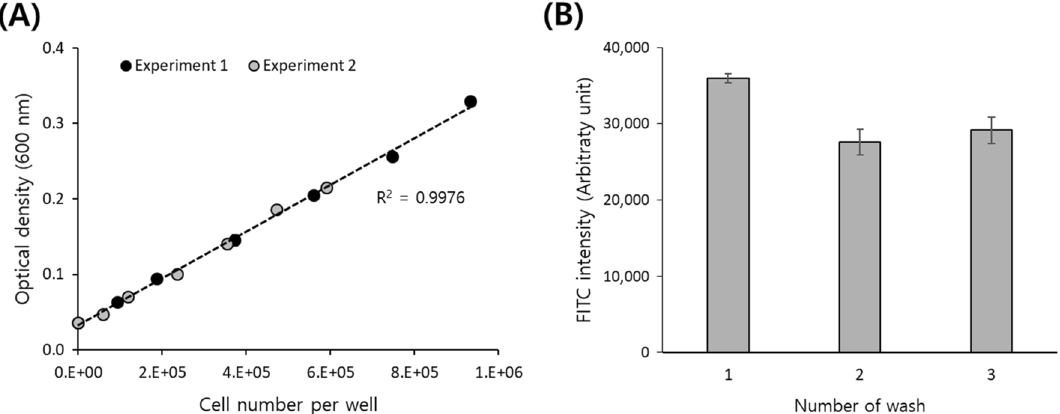
Figure 2. ( A ) Correlation between cell number and optical density measured at 600 nm and ( B ) FITC intensity change by repeated washing of Jurkat